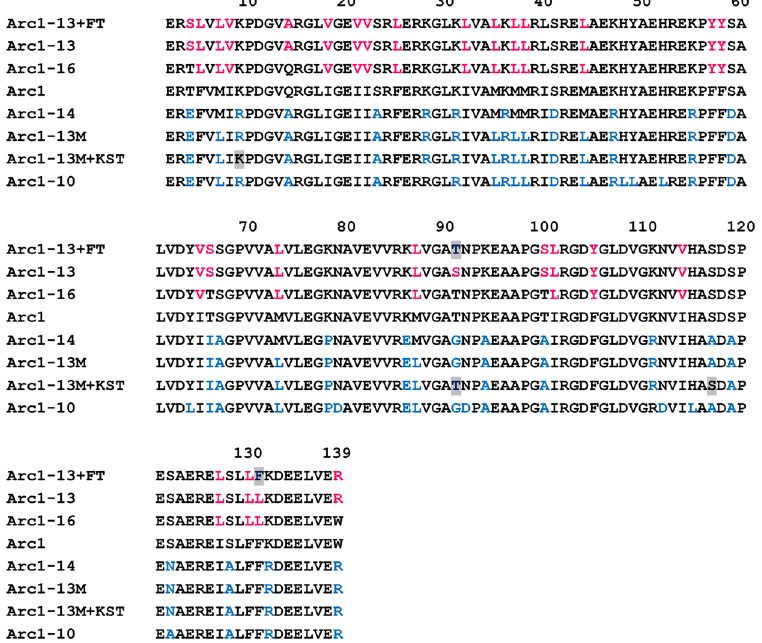
Figure 2. Amino acid sequences of Arc1 and its simplified variants. N-terminal residue(s) were omitted from this alignment. The substituting amino acids are shown in magenta or blue. Gray shading indicates residues restored to the original ones because they are almost completely conserved among extant NDK